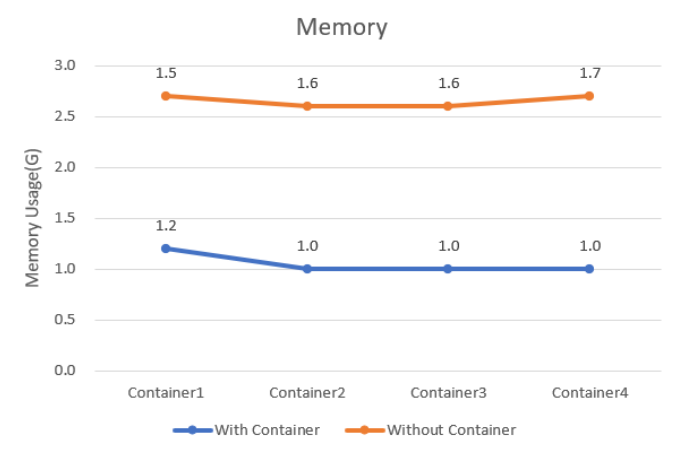
Figure 16. The Graph representations usage of memory with and without